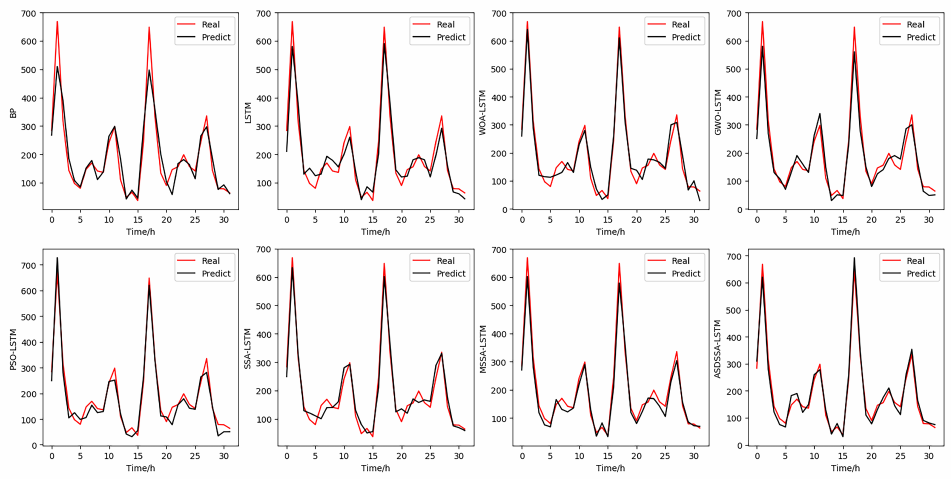
Figure 10. Prediction results of eight